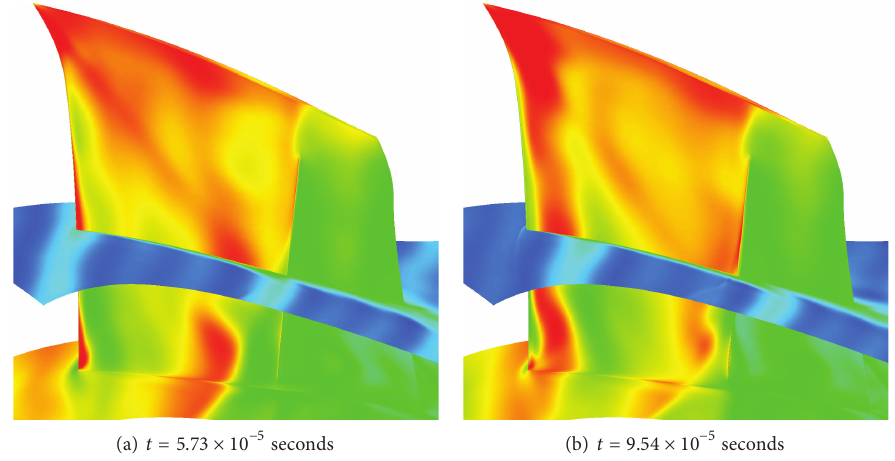
F 16: e rotor one wake depicted by instantaneous entropy contours on the rotor two blade and a 40 50 of the slot span). Red is high entropy, blue is low %